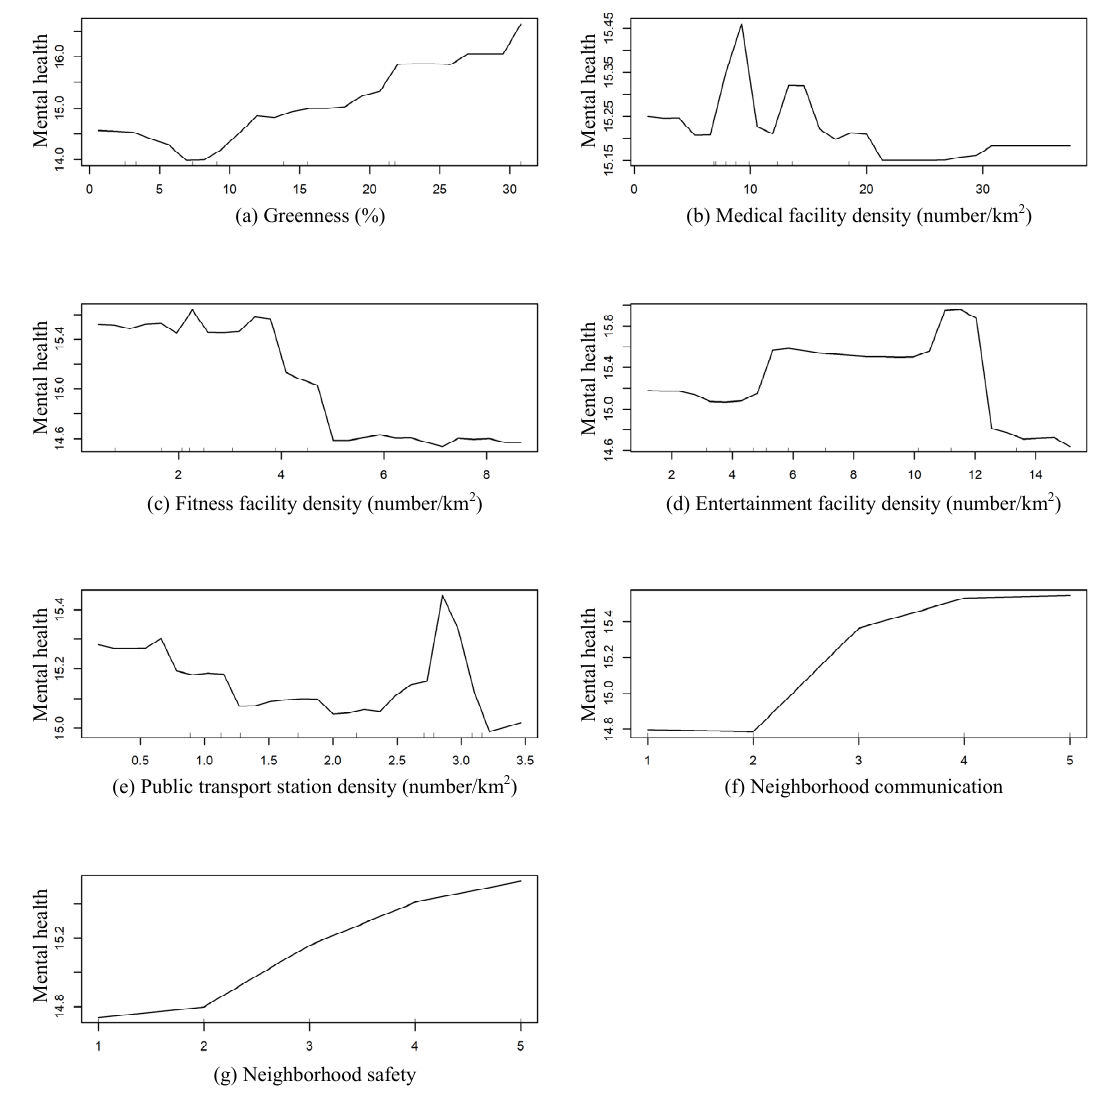
Figure 3. Nonlinear effects of neighborhood environments on mental health.